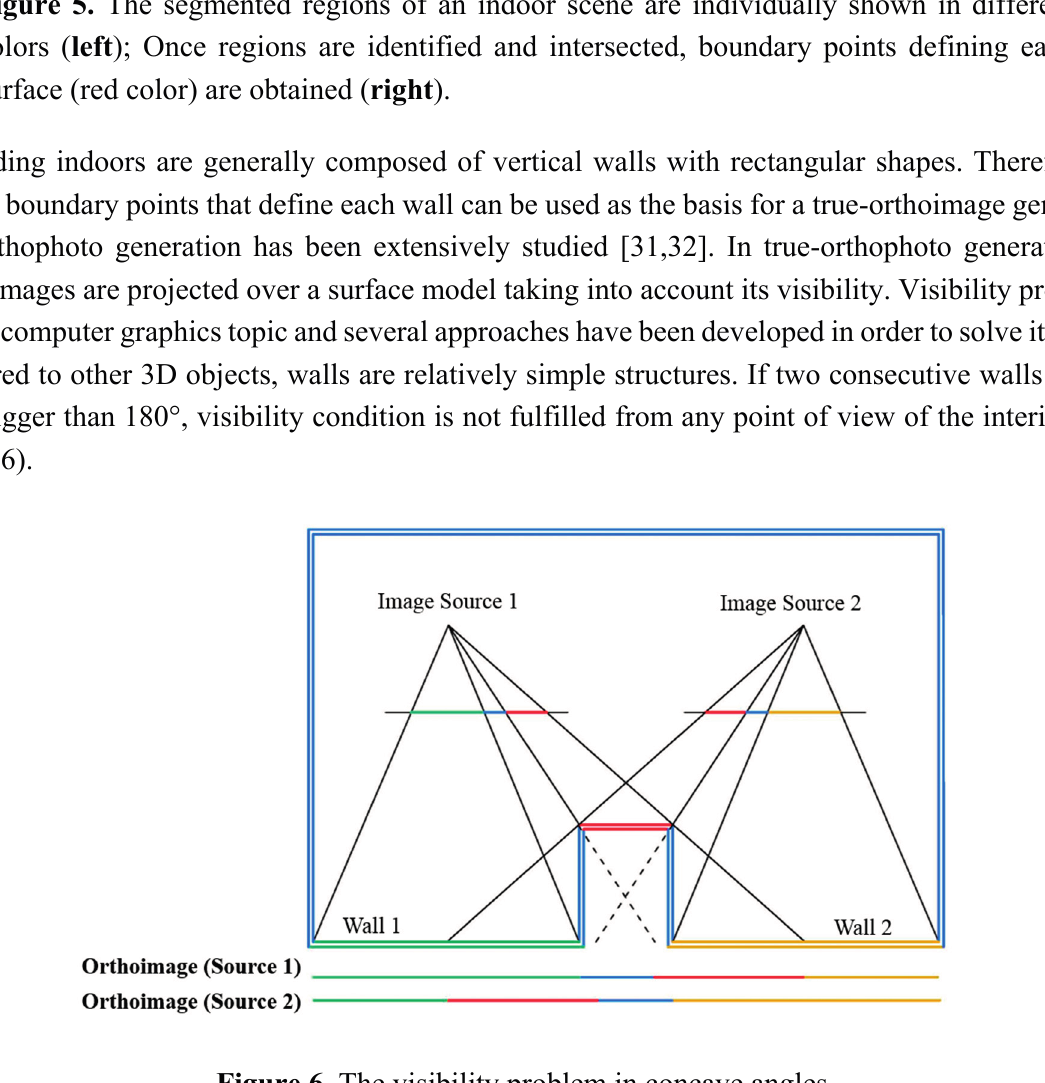
Figure 6. The visibility problem in concave